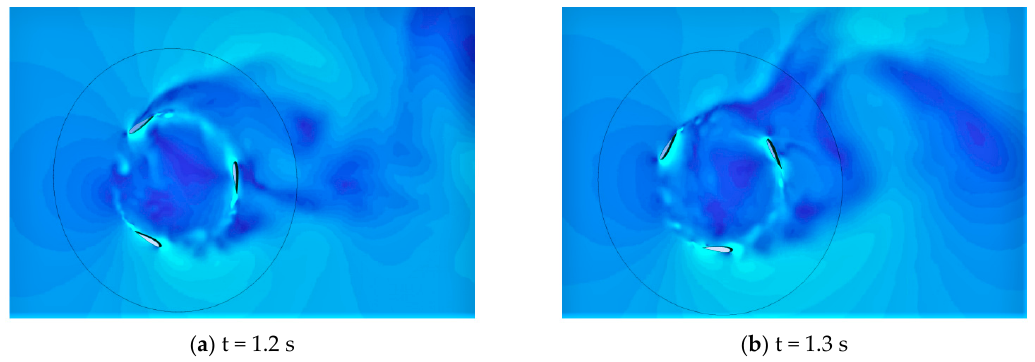
Figure 4. Velocity magnitude flow field for isolated VAWT at two instants at time: ( a ) t = 1.2 s and ( b ) 1.3 s.